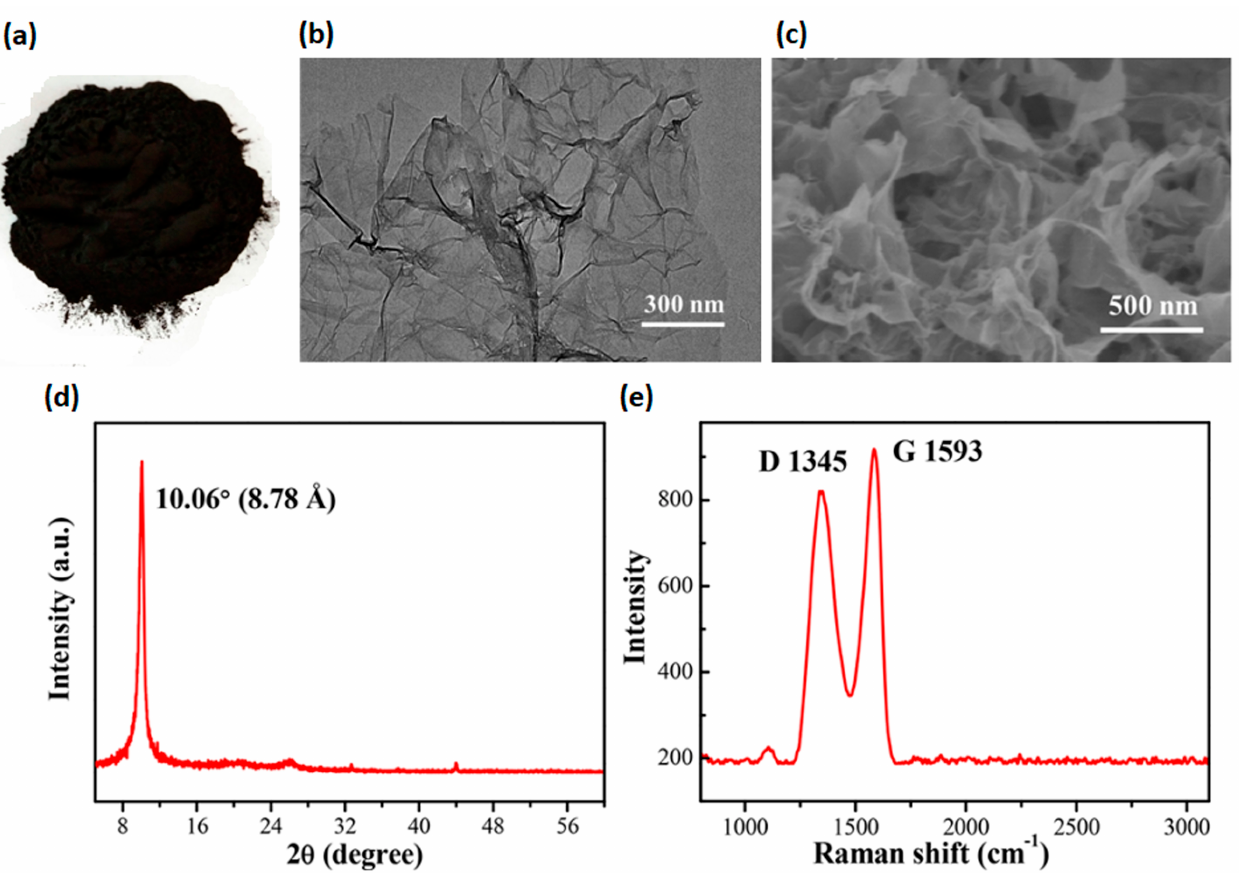
Figure 4. ( a ) Optical photograph; ( b , c ) SEM images of 3D porous GO with different magnifications; (right) TEM images with different magnifications; ( d ) XRD and ( e ) Raman spectrum. Reprinted with permission from [95]. Copyright 2022 American Chemical Society.